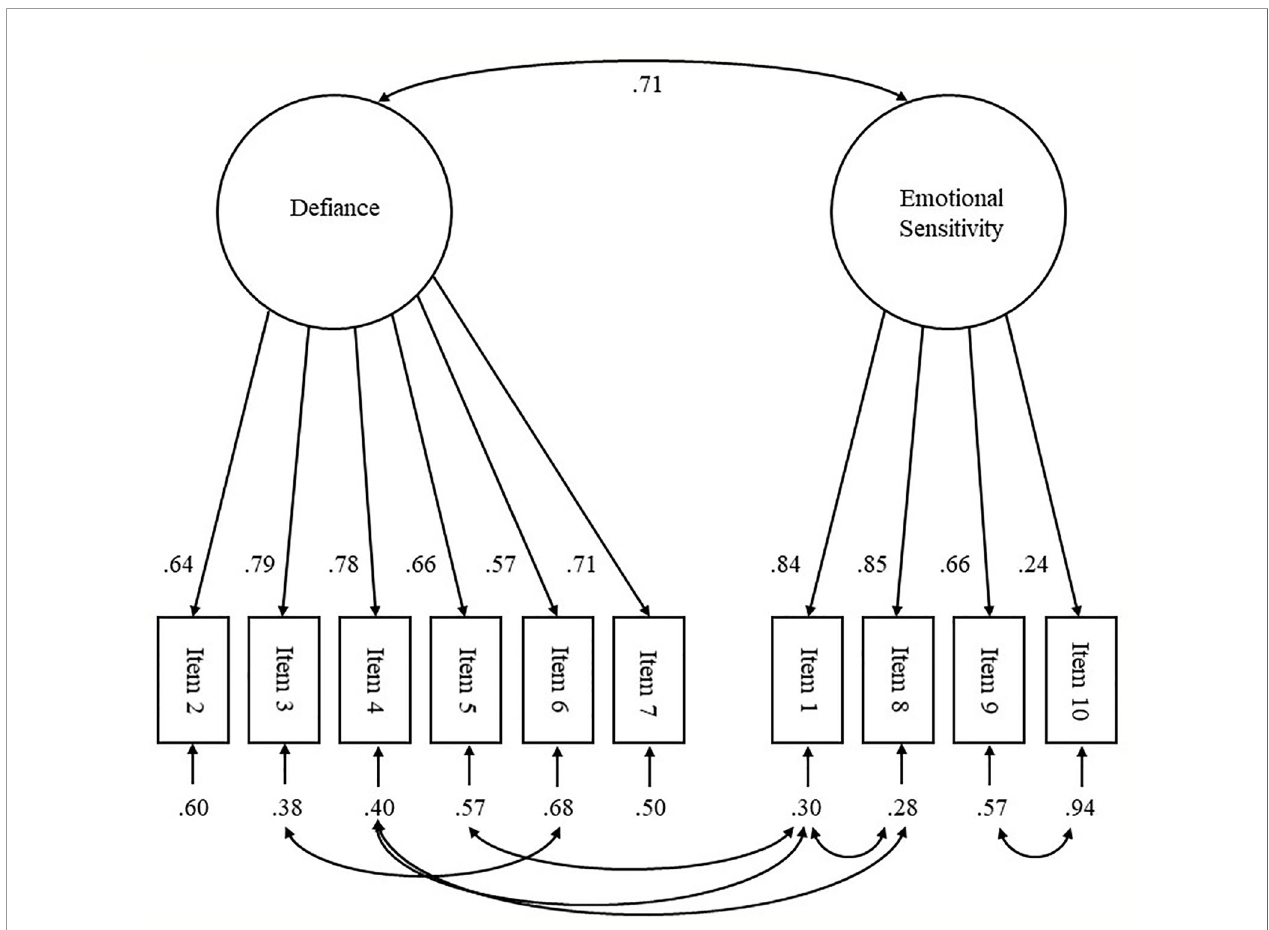
FIGURE 1 | Standardized factor loadings of Hoodin and Kalb fl eisch ’ s (10) TERS two-factor model with 7 freed error covariances. Squares represent TERS items, circles indicate the two associated latent factors. All loadings are statistically signi fi cant (p <